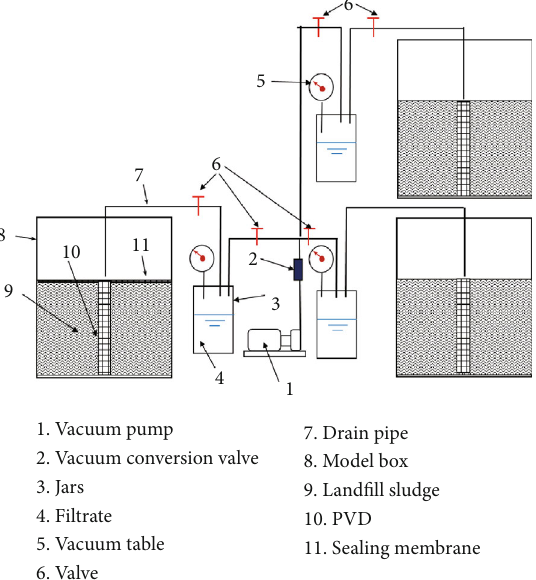
Figure 5: Schematic diagram of the test device.